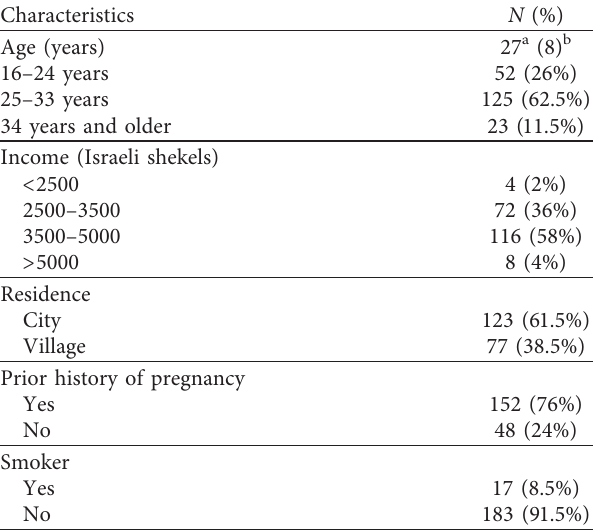
Table 1: Sociodemographic characteristics of participants.